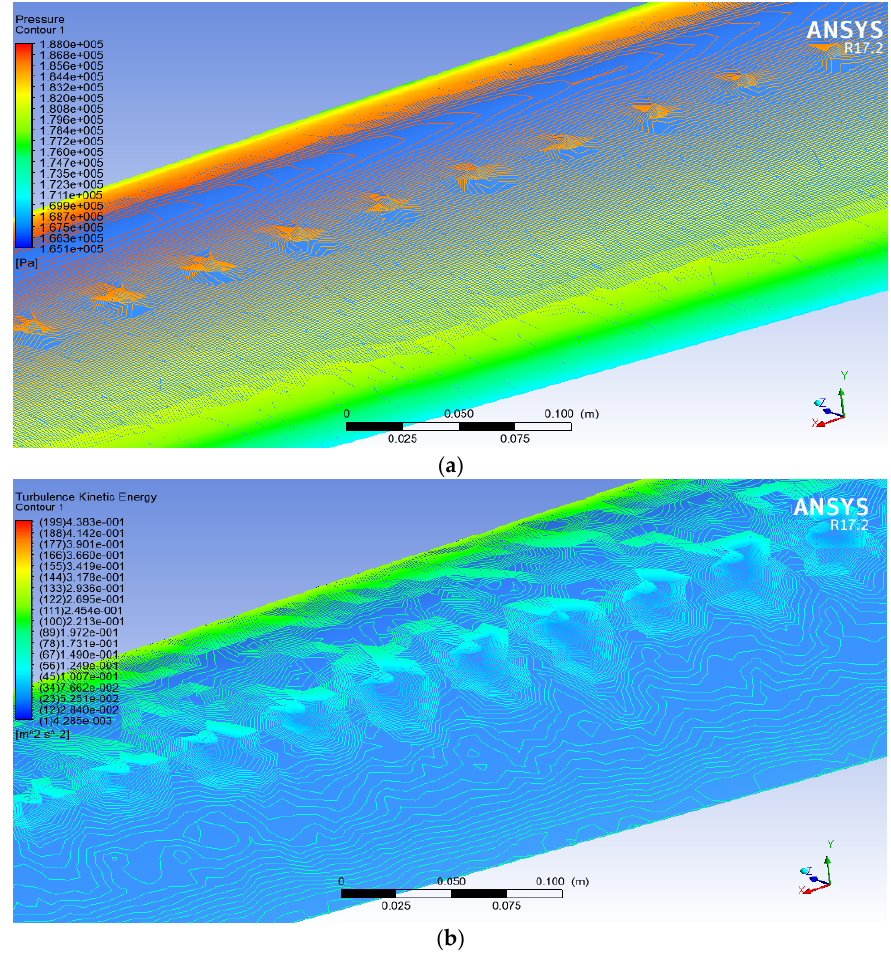
Figure 9. Disturbance resulted by the surface bumps. ( a ) Pressure ( b ) Turbulence kinetic energy. Table 2. The P max and P min obtained when the current speed is 3.2 m/s and pitch angle is 0 ◦ . Scenarios P min (Pa) P max (Pa) Blade without